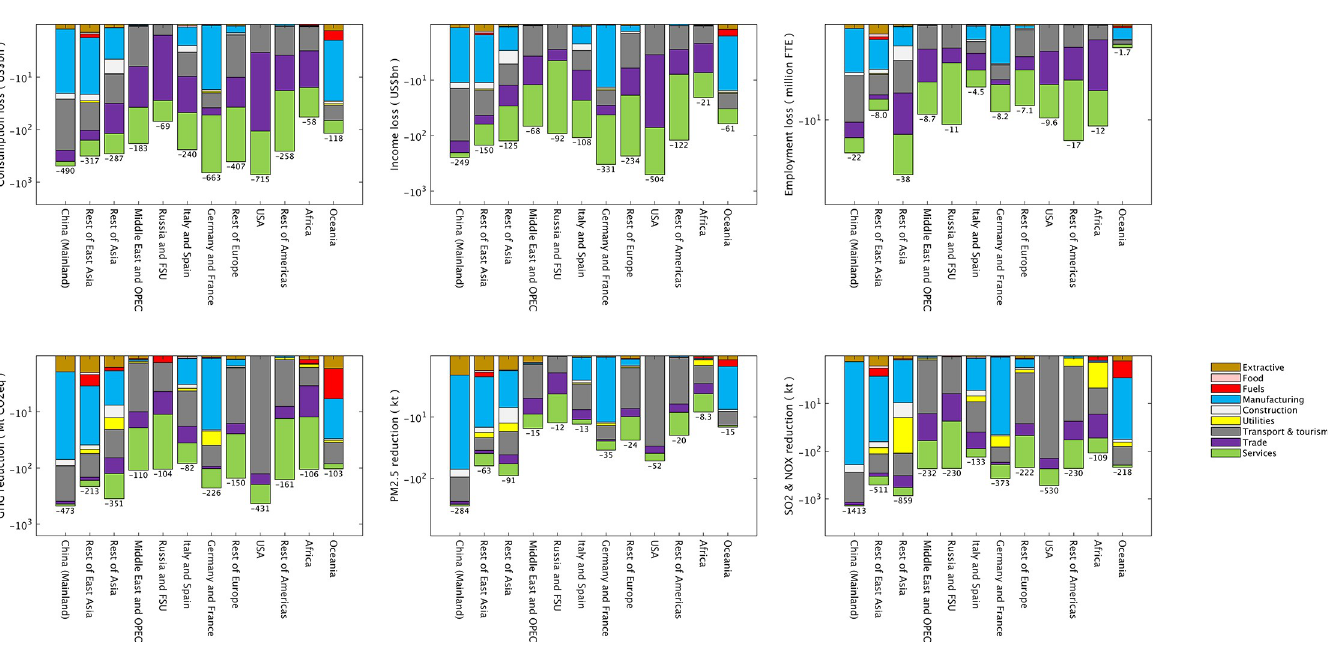
PLOS ONE | https://doi.org/10.1371/journal.pone.0235654 July 9,